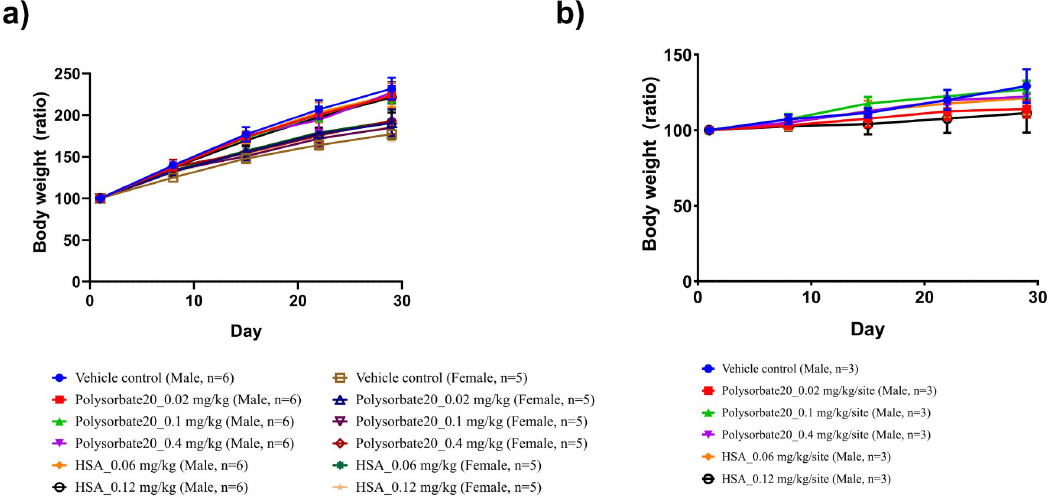
Fig 1. Body weight changes in a four-week repeated intramuscular dose toxicity study in Sprague-Dawley (SD) rats and an intradermal irritation study in New Zealand White (NZW) rabbits. Body weight changes measured once a week in a) SD rats and b) NZW rabbits, for a total of five times during the study period. In SD rats, all substances were injected once every two weeks for four weeks (total three times; days 1, 15, 29) into one site of the gastrocnemius muscle of the right hindlimb. Neither male nor female rat groups showed significant differences in body weight on days 8, 15, 22, and 29 (Kruskal-Wallis test). In NZW rabbits, all substances were injected once into five sites of the back skin (total one time; day 1). There was no significant difference in body weight on days 8, 15, 22, and 29 in all groups (Kruskal-Wallis